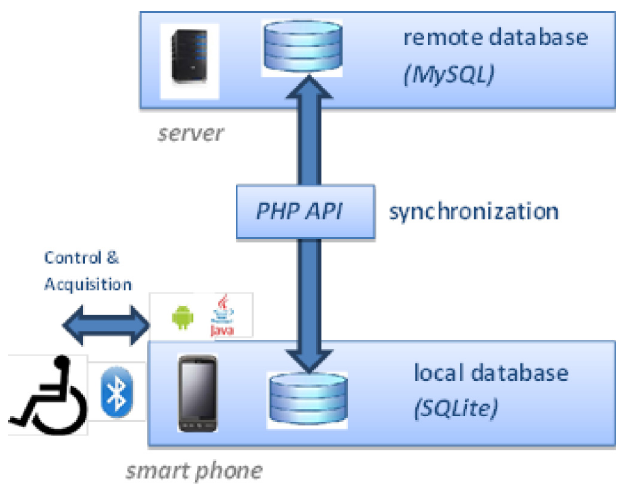
Figure 12. System physical architecture.